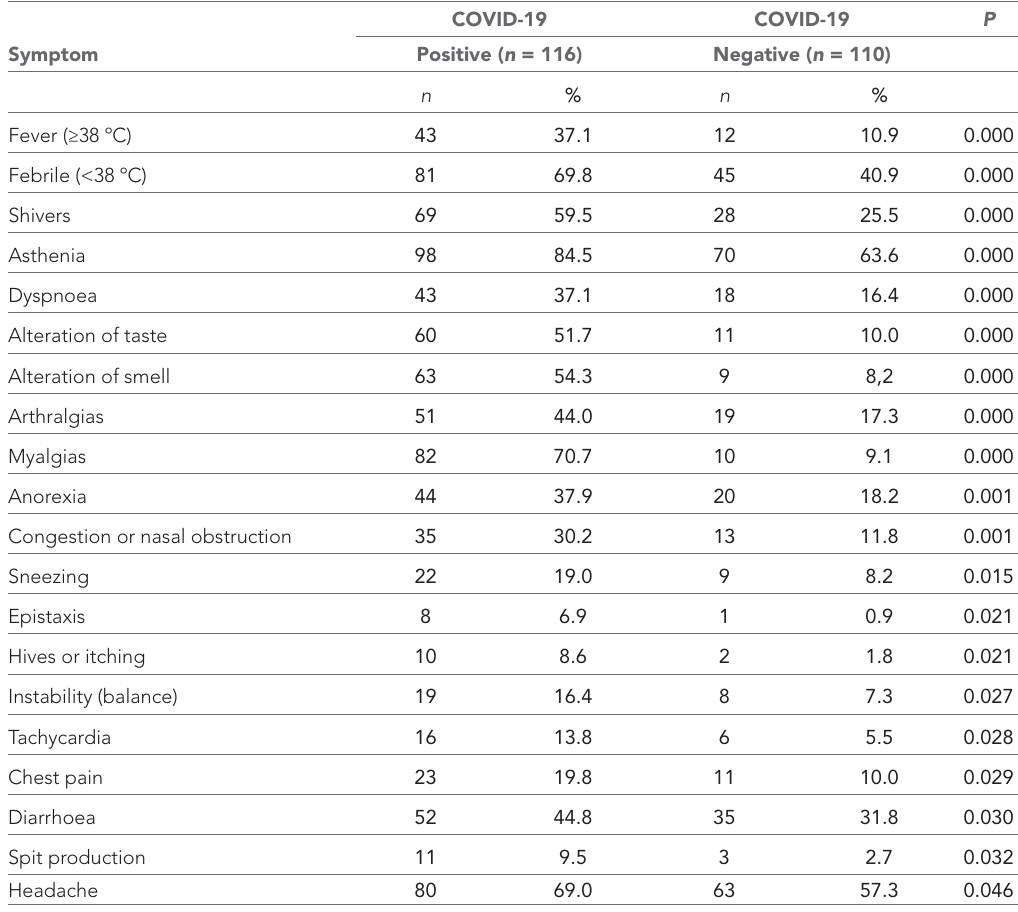
Table 1 Clinical characteristics of the sample, at any